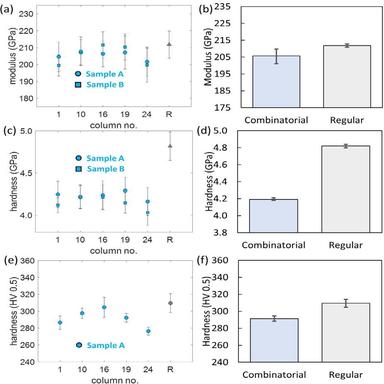
Comparison of indentation measurements for default laser parameters on combinatorial columns and a regular sample in the as-built condition. (a, c, and e) have individual column averages ± one standard deviation compared to the regular (R) sample average ± one standard deviation. Two samples (Sample A and B) were included for nanoindentation measurements. (b, d, and f) compare the expected values and their 95% confidence intervals. The combinatorial sample confidence intervals were determined according to